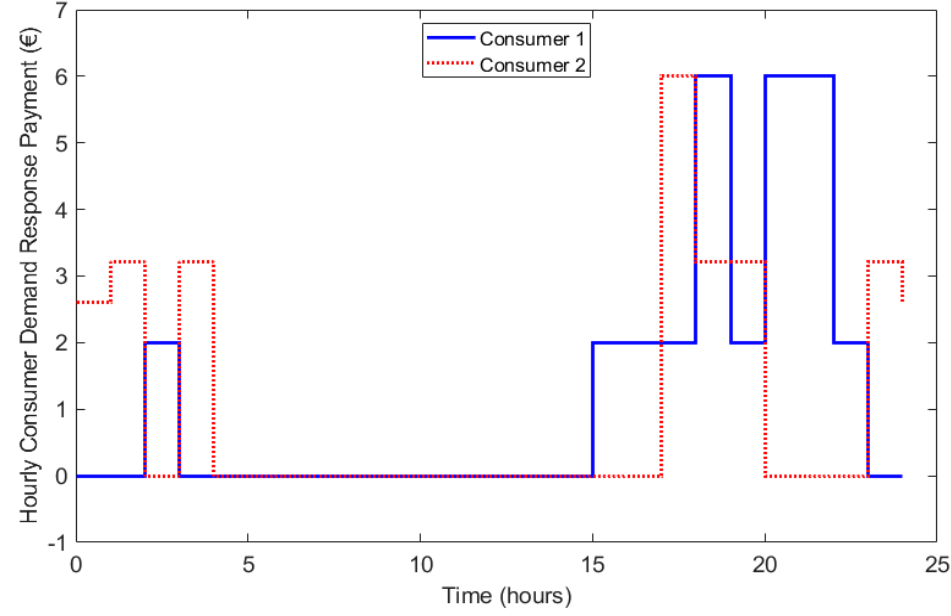
Figure 13. Hourly consumer payment.